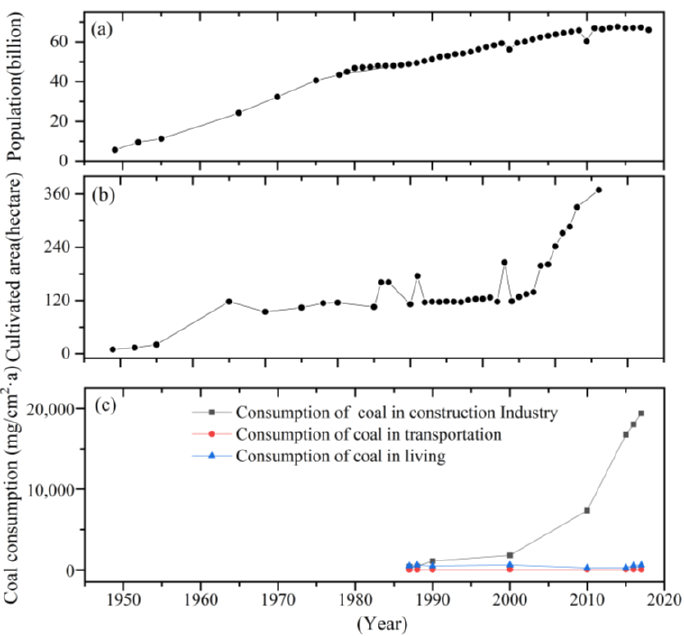
Figure 6. The population ( a ), cultivated area ( b ), and coal factors ( c ) (industry, transportation, and living consumption) of the Altay region.